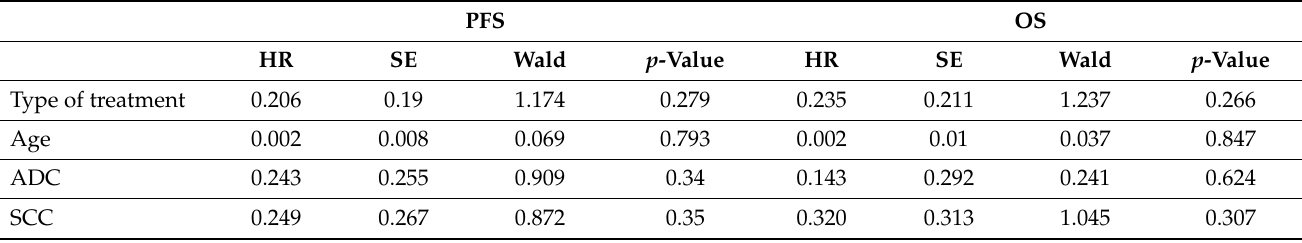
Table 5. Statistics for the variables in the tested model.